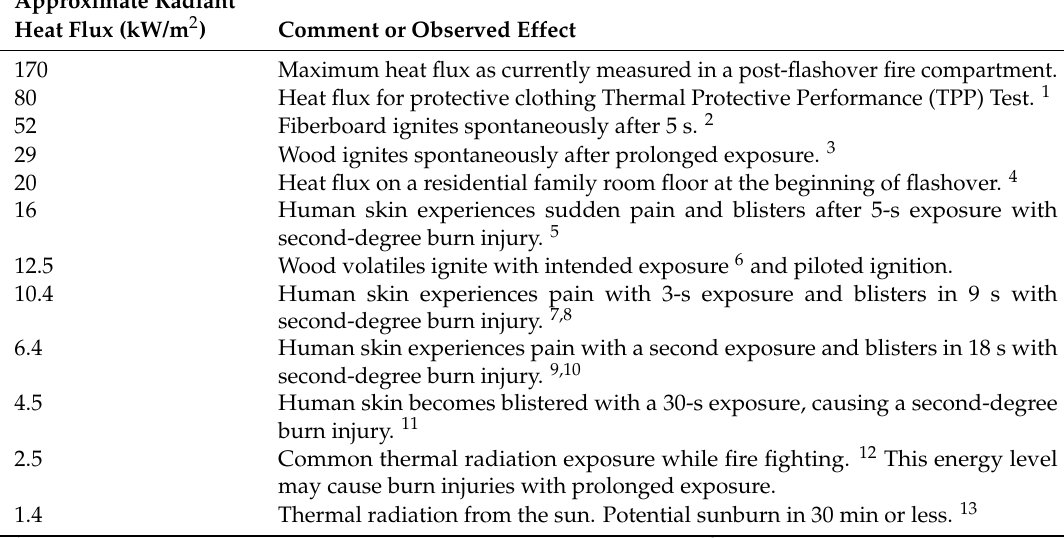
Table 3. Approximate radiant heat flux [4].